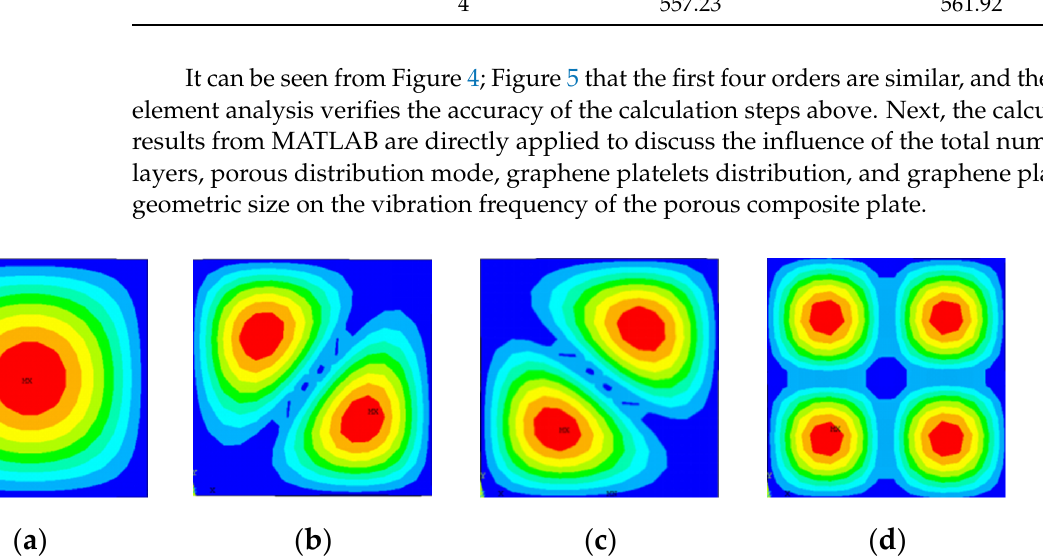
Figure 5. The first four-order vibration of MATLAB. ( a ) First order vibration mode, ( b ) second order vibration mode, ( c ) third order vibration mode, and ( d ) fourth order vibration mode. 5. Calculation and Discussion 5.1. Analysis of Stratified Convergence of GPL Reinforced Porous Composite Plate and the Influence of Boundary Conditions The free vibration frequency of the composite plate with different layers and different boundary conditions when the porous distribution, with a porosity distribution A, is cal- culated, and the results are shown in Table 3.